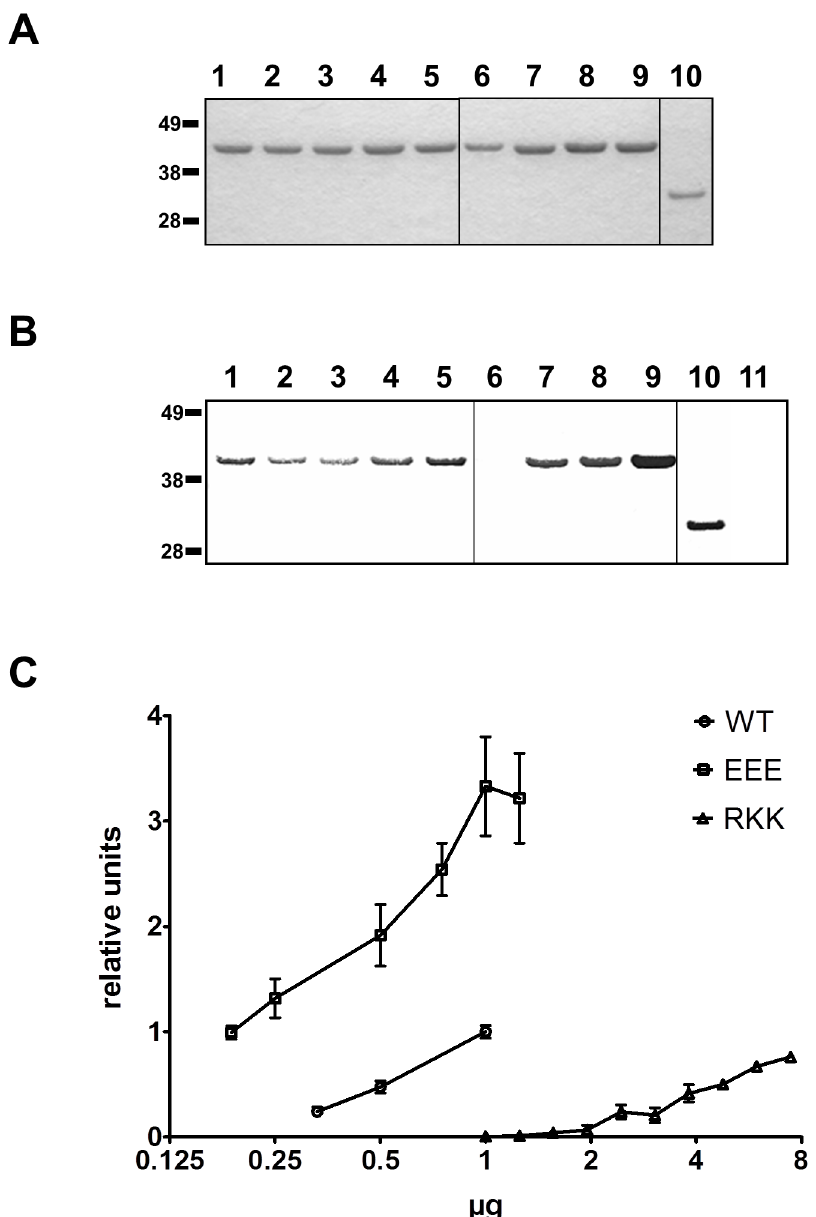
Fig 4. DNA binding activity of PilG alanine substitution mutants. (A) Coomassie Blue-stained SDS-PAGE and (B) South-western assay with the indicated PilG alanine substitution mutants using oligomer HH9 as DNA probe (see Table 2). Protein amount were 1 μ g/lane for PilG proteins and 0.25 μ g/lane for Fpg. Lane 1, PilG FL/1-410 ; lane 2, PilG K3A ; lane 3, PilG KK12-13AA ; lane 4, PilG KR15-16AA ; lane 5, PilG E14A ; lane 6, PilG E41H/RKK43-45AAA ; lane 7, PilG SS62-63AA ; lane 8, PilG Q55A ; lane 9, PilG EEE39-41AAA ; lane 10, Fpg; lane 11, BSA. Similar results were obtained with all DNA substrates employed (see Table 3). The positions of the protein size standards (kDa) are shown on the left. (C) Relative level of bound DNA substrate South-western at different protein concentrations of recombinant PilG FL (WT), PilG RKK43-45AAA (RKK), and PilG EEE39-41AAA (EEE) measured by densitometry and plotted as relative units with the average value for 1 μ g PilG FL set to 1. The results of at least three experiments using ssDNA and dsDNA are shown. No significant substrate specificity was